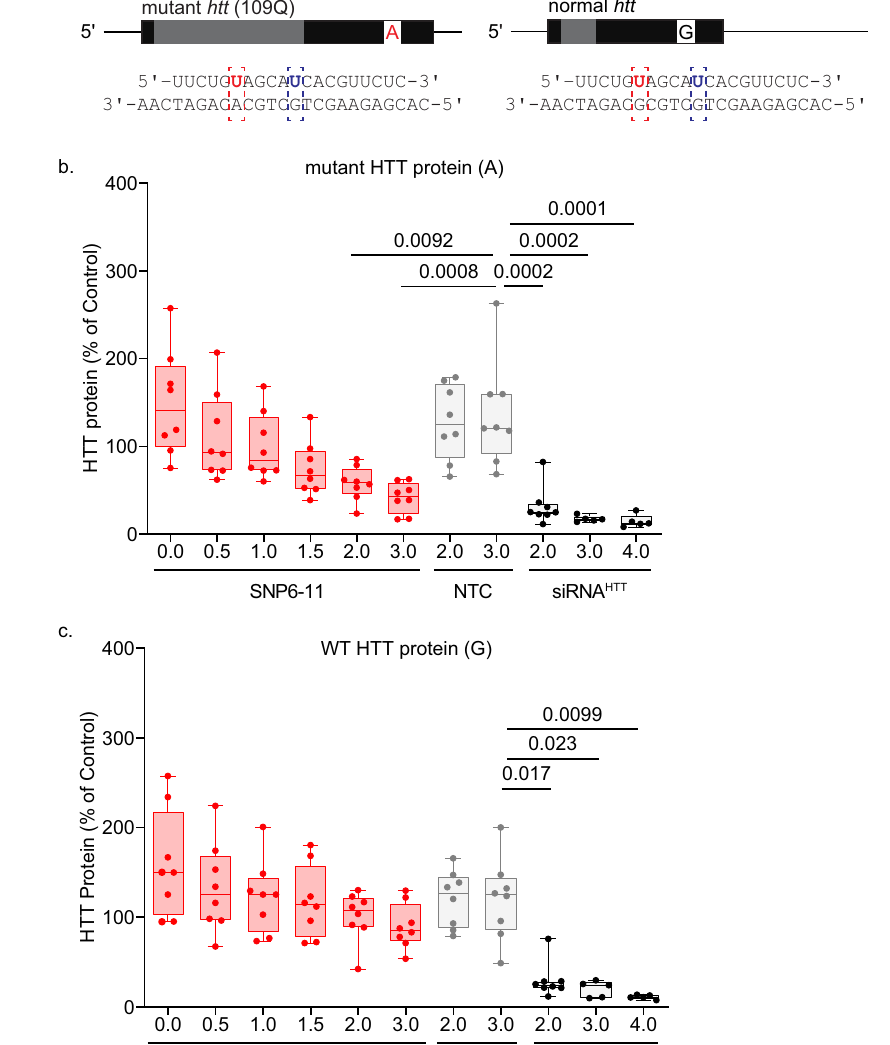
negative control. Non-selective targeting with siRNA HTT was used as a positive control.One-wayANOVAandposthocTukeytest; n =5wellsforsiRNA HTT at3.0and 4.0 µ M, n =8 wells per group for the remaining treatments. Error bars extend to minimum and maximum value. The lower bound of the box is the 25th percentile and the upper is the 75th, with a line at the median. Source data are provided as a source data fi